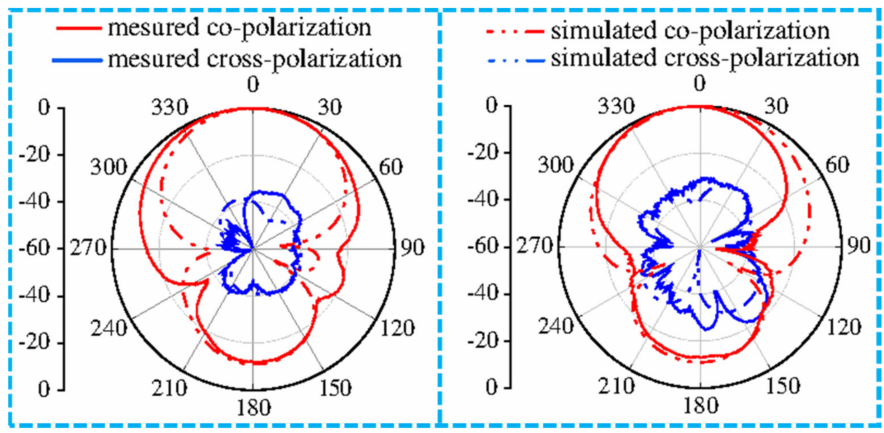
Figure 10. Simulation and measurement far field results at 915 MHz inside the skin-gel.